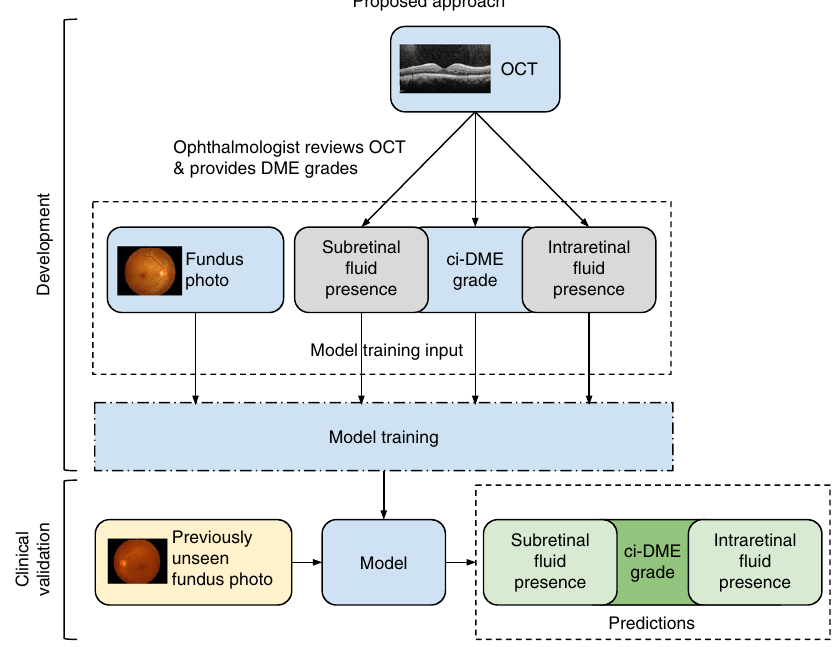
Fig. 1 Illustration of our proposed approach for developing a ci-DME model. Ground truth for ci-DME were derived from a human grader analyzing the OCT for each case. In addition, subretinal fl uid and intraretinal fl uid presence grades were also collected. These ground truth labels and corresponding color fundus photos were used for model training. For clinical validation, the trained model takes in a new fundus photo and generates a predicted ci-DME grade, predicted subretinal fl uid, and intraretinal fl uid presence